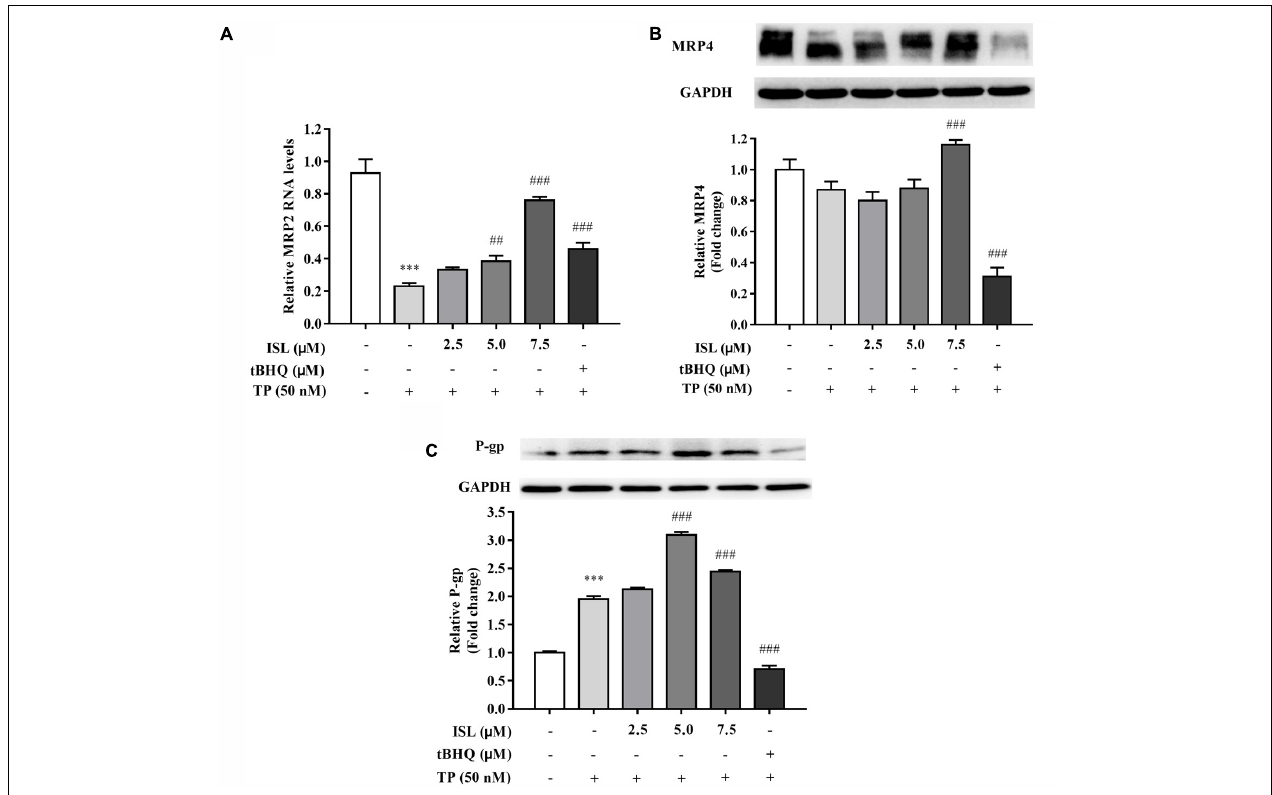
FIGURE 3 | ISL pretreatment induced expressions of (A) MRP2, (B) MRP4, and (C) P-gp to protect against TP-induced cytotoxicity. L02 cells were treated with 50 nM TP with or without 2.5, 5, and 7.5 µ M ISL pretreatment. The tert -butylhydroquinone (15 µ M) was used as an Nrf2 inducer. RT-PCR was used to analyze mRNAs and proteins by Western blot. Data were presented as means ± SE ( n = 3); ∗∗∗ P < 0.001 vs. the control group, ## P < 0.01 vs. the TP group, and ### P < 0.001 vs. the TP group.